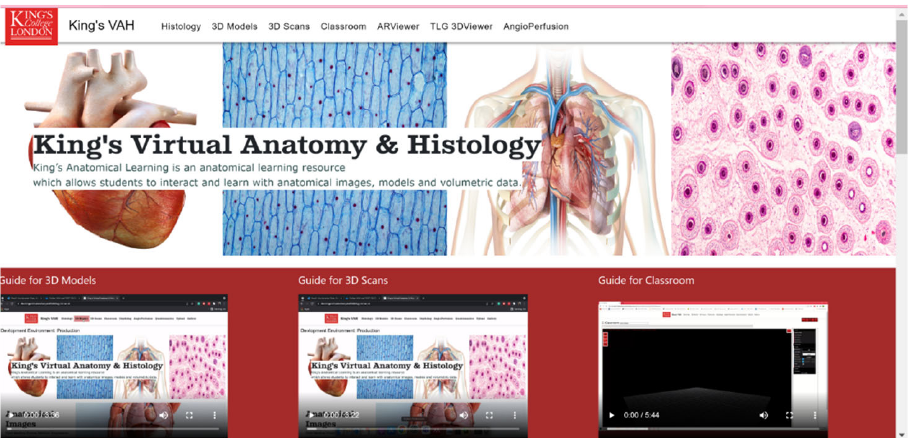
3D model viewer, 3D scans (volumetric) viewer, augmented reality (AR) viewer, and TLG